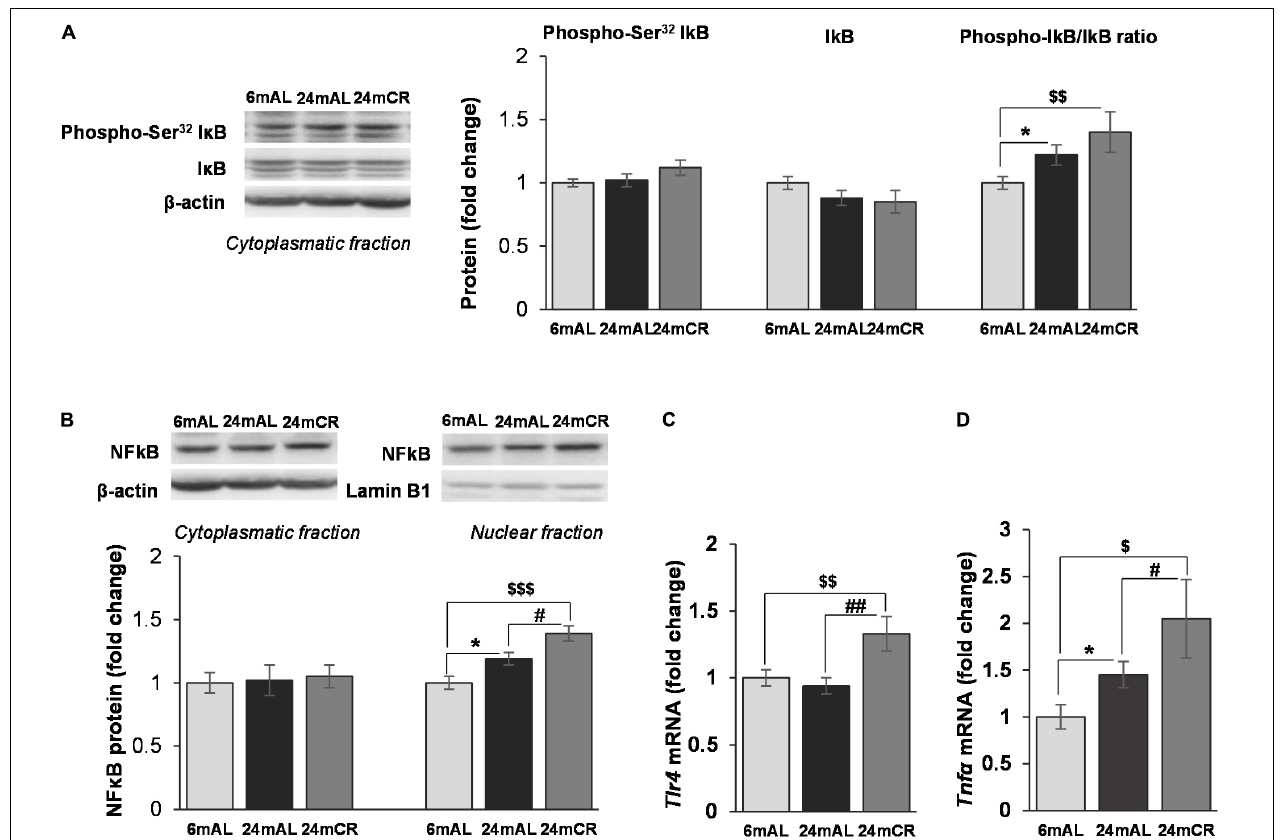
FIGURE 4 | The levels of phosphorylated and total I κ B and protein and gene expression of proinflammatory mediators in the liver. Representative Western blots and relative quantification of phospho (Ser32) and total I κ B in cytoplasmatic (A) and NF κ B protein level in citoplasmatic and nuclear fractions (B) of the liver of adults (6 mAL), aged rats on AL diet (24 mAL), and old rats on CR (24 mCR). β -actin and Lamin B1 were used as loading controls for cytoplasmatic and nuclear fraction, respectively. Quantification of Tlr4 (C) and Tnf α (D) mRNA levels in the liver was done relative to the amount of β -actin. All values are given as means ± SEM ( n = 8). Asterisk indicates a significant difference between aged rats on AL diet and adults (24 mAL vs. 6 mAL, * p < 0.05), hashtag indicates a significant difference between old rats on different diet regimes (24 mCR vs. 24 mAL, # p < 0.05, ## p < 0.01), and symbol $ denotes a difference between old rats on CR and adults on AL diet (24 mCR vs. 6 mAL, $ p < 0.05, $$ p < 0.01, $$$ p < 0.001).